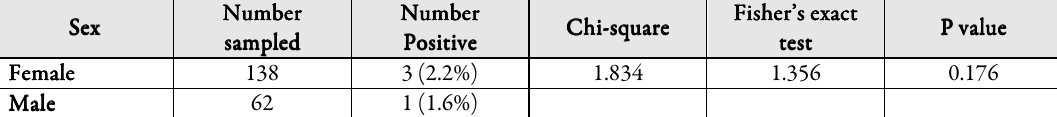
Table 3. Chi-square test-based association analysis of trypanosomosis in male and female trade